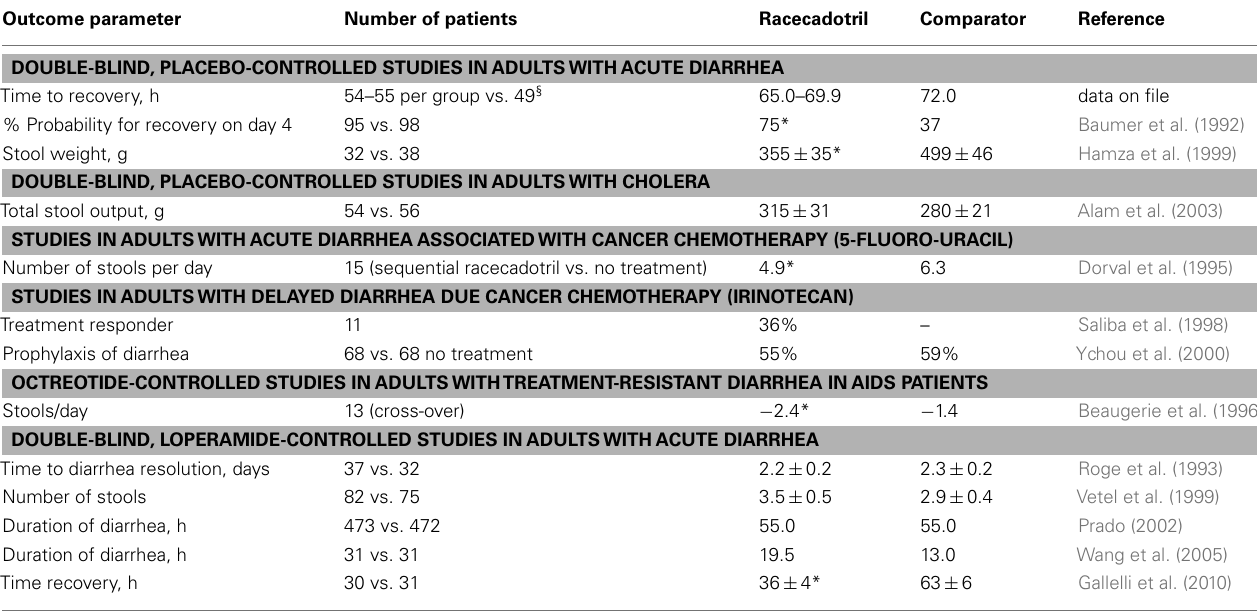
Table 1 | Efficacy of racecadotril in the treatment of acute diarrhea in adults. Outcome